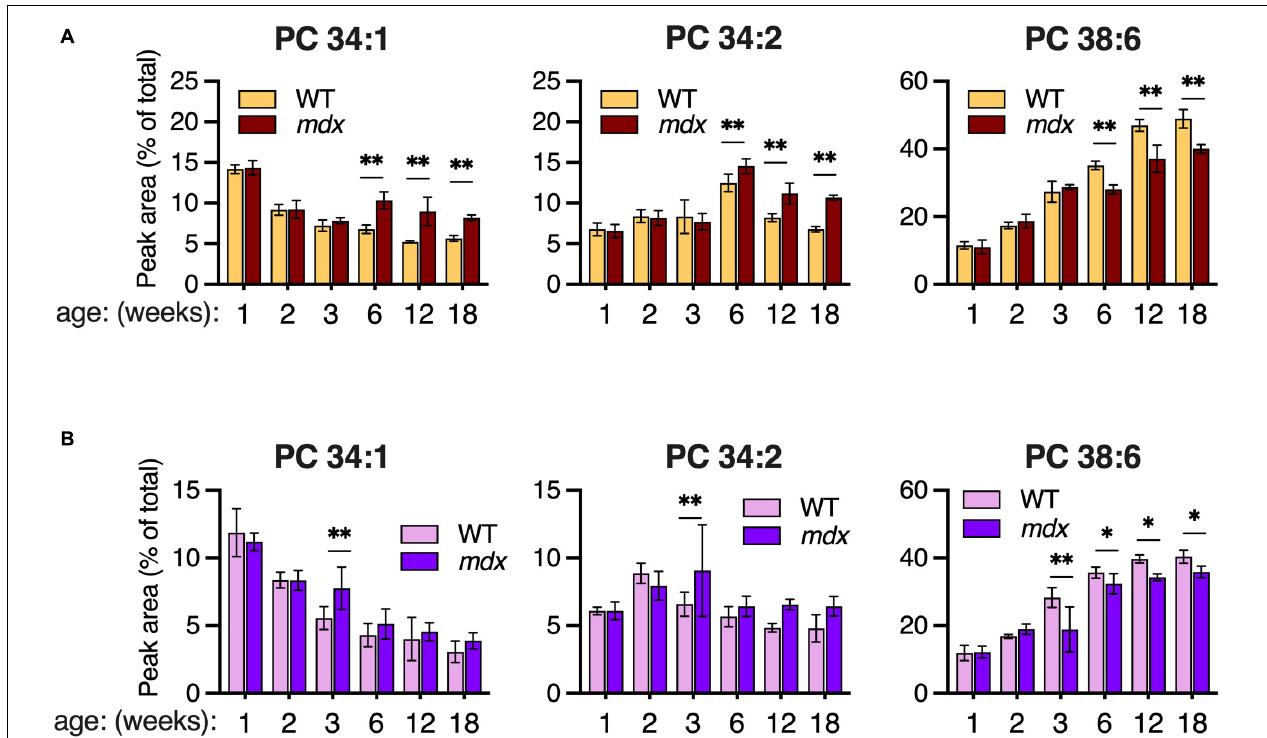
FIGURE 5 | Time course of major PC alterations in EDL and SOL of 1–18-week-old B10-WT and - mdx mice raised on CE-2 standard chow. PC compositions were measured by LC-MS/MS and means ± SD are plotted. In EDL (A) , high mdx -levels of PC 34:1 and PC 34:2 and reduced mdx -levels of PC 38:6 were detected at ages 6-, 12-, and 18-weeks. In SOL (B) , these alterations tended to be detected earlier at age 3-weeks and were diminished at later time points. Significant differences between corresponding WT and mdx muscles were determined by FDR-controlled multiple t -tests (FDR < 5%). ∗ p < 0.05, ∗∗ p < 0.01; n = 3–8 mice/group; includes identical data shown in Figure 3 (18-week-old) and Figure 4 ( 2-, 6-, and